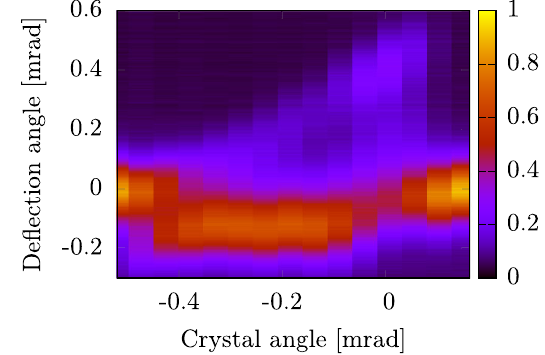
FIG. 4. The probability density relative to the maximum probability density of the deflected particles as a function of the crystal angle for the case of 3.35 GeV electrons.